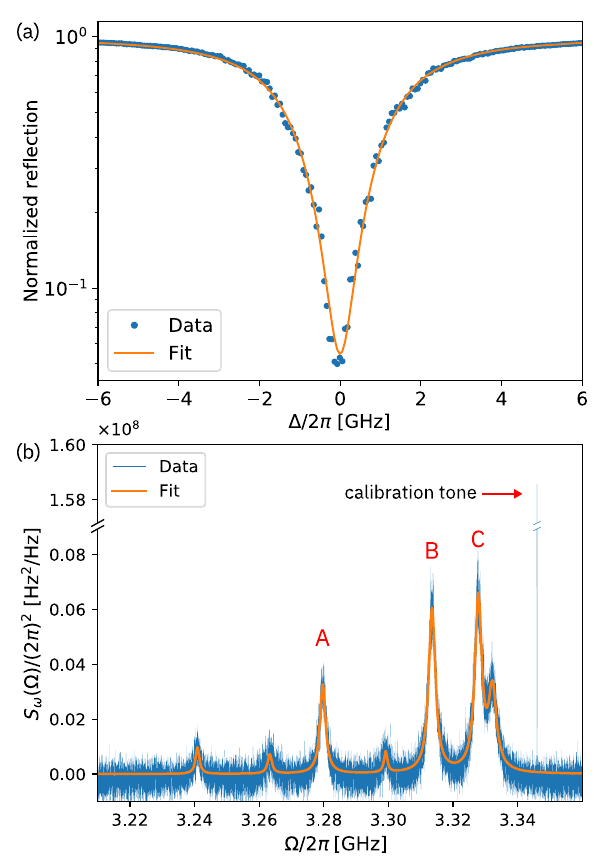
Fig. 3 Optical and thermo-mechanical spectroscopy. a Fit (orange) of Eq. (1) to the optical re fl ection spectrum (blue) of the cavity resonance. b Thermo-mechanical spectrum (blue) plotted as symmetrized frequency noise spectral density S ω ( Ω ) with a fi t to a sum of Lorentzian functions (orange). The data are calibrated with an added tone created by a phase modulator. The assignment to the modes shown in Fig. 1(k) is indicated by A, B, and